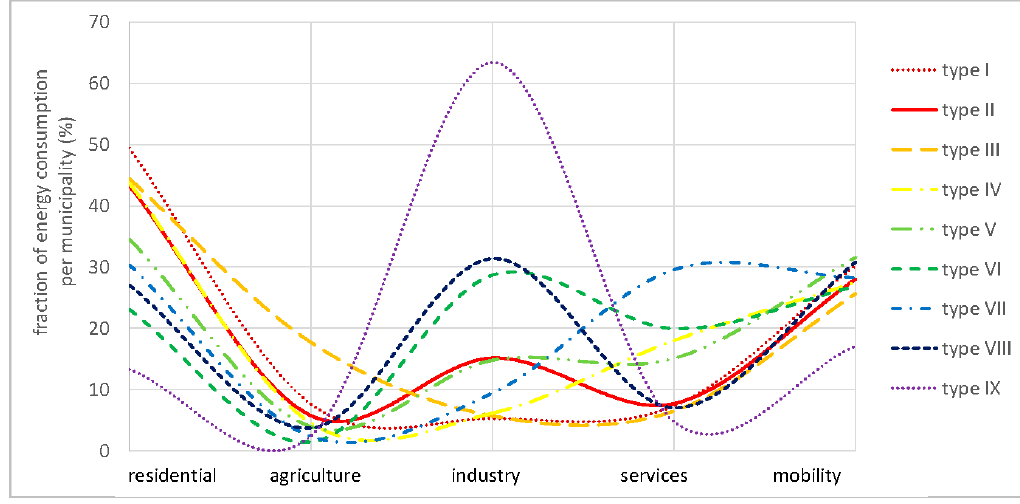
Figure 9. The municipality types with similar patterns of energy consumption.